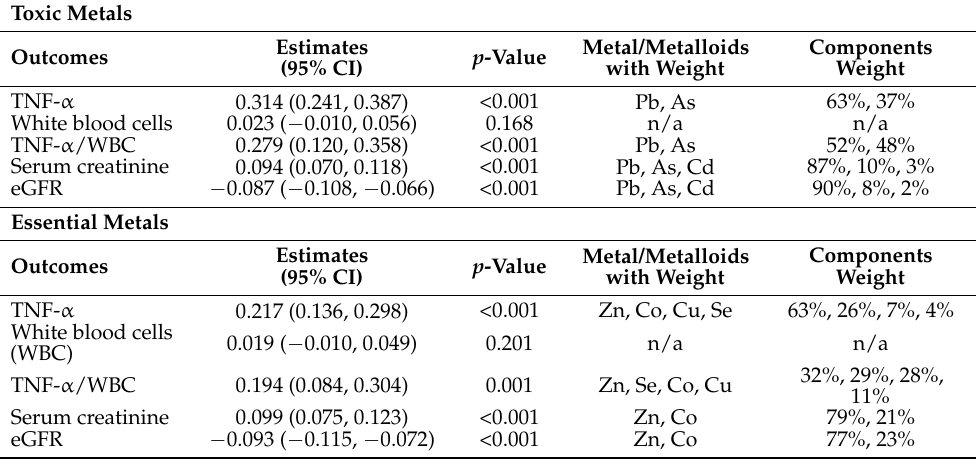
Table 2. Results for toxic metals and essential metal mixtures by WQS regression analyses after adjusting for age, gender, BMI, smoking status, and alcohol consumption